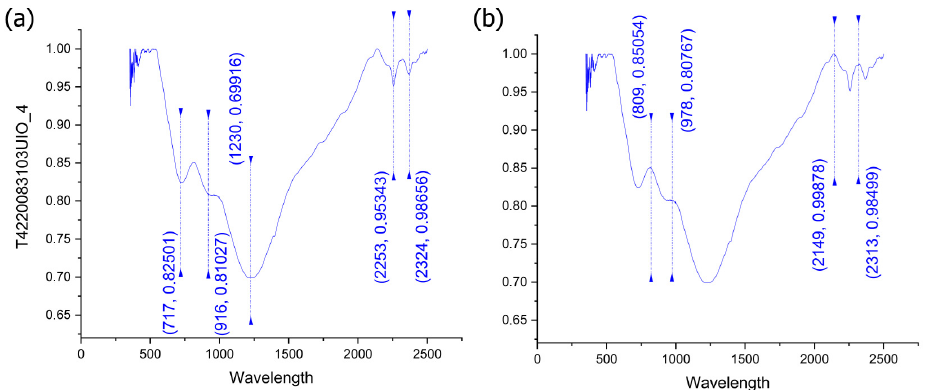
Figure 12. Absorption and reflectance peaks from spectra collected from samples of Tysfjord biotite. ( a ) Main absorption peaks (minimum). ( b ) Main reflectance peaks.